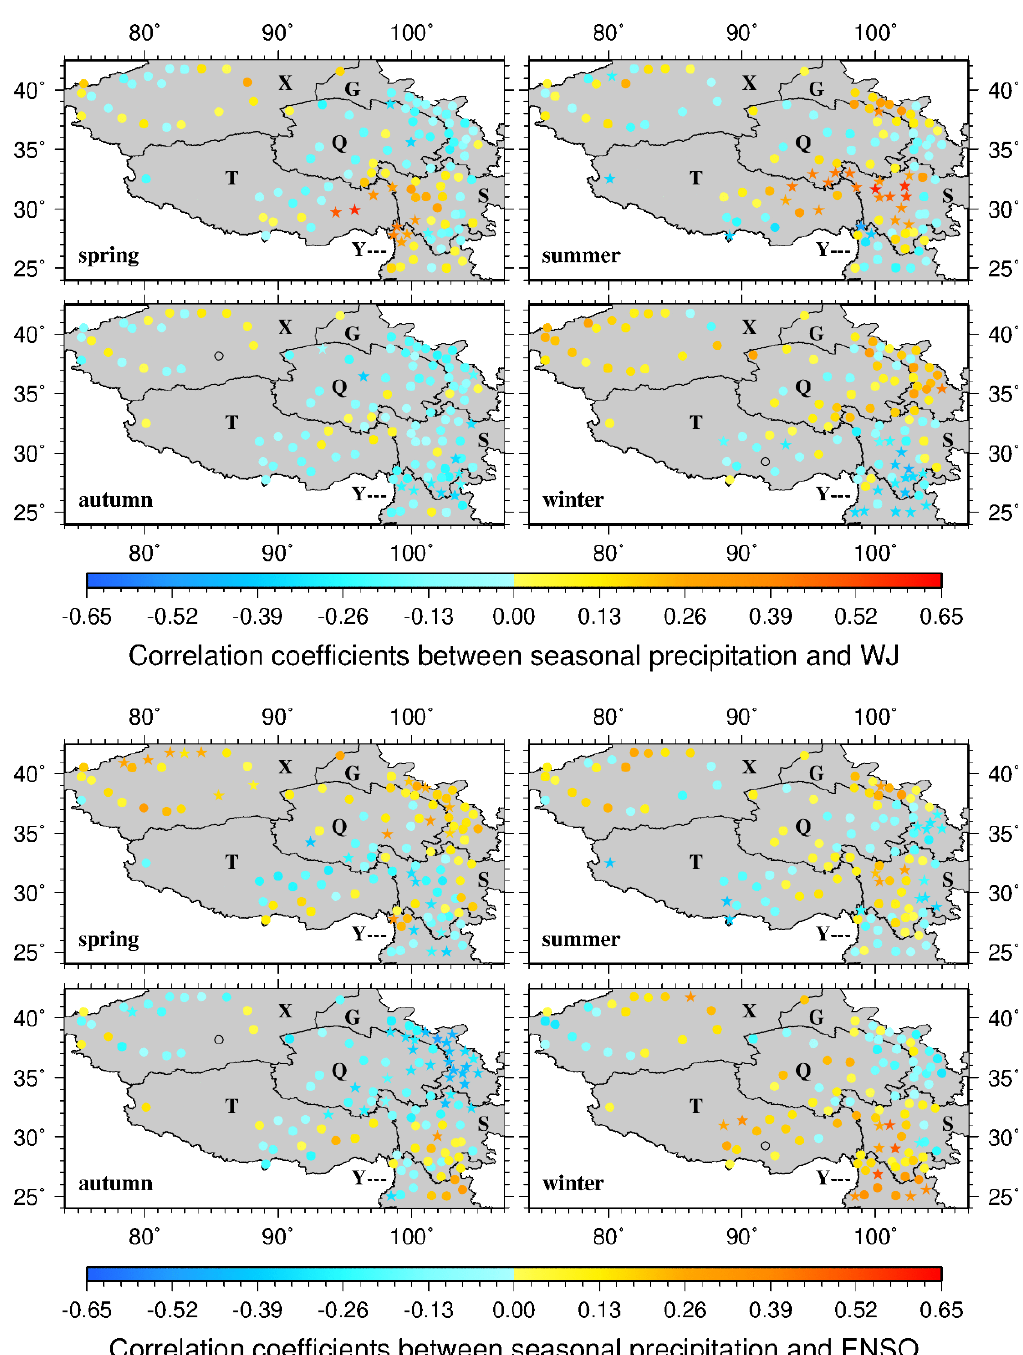
Figure 9. Spatial distributions of correlation coefficients between monthly precipitation and WJ and ENSO. Stars represent statistically significant trends ( p < 0.05). Open circles denote zero corre- lations.